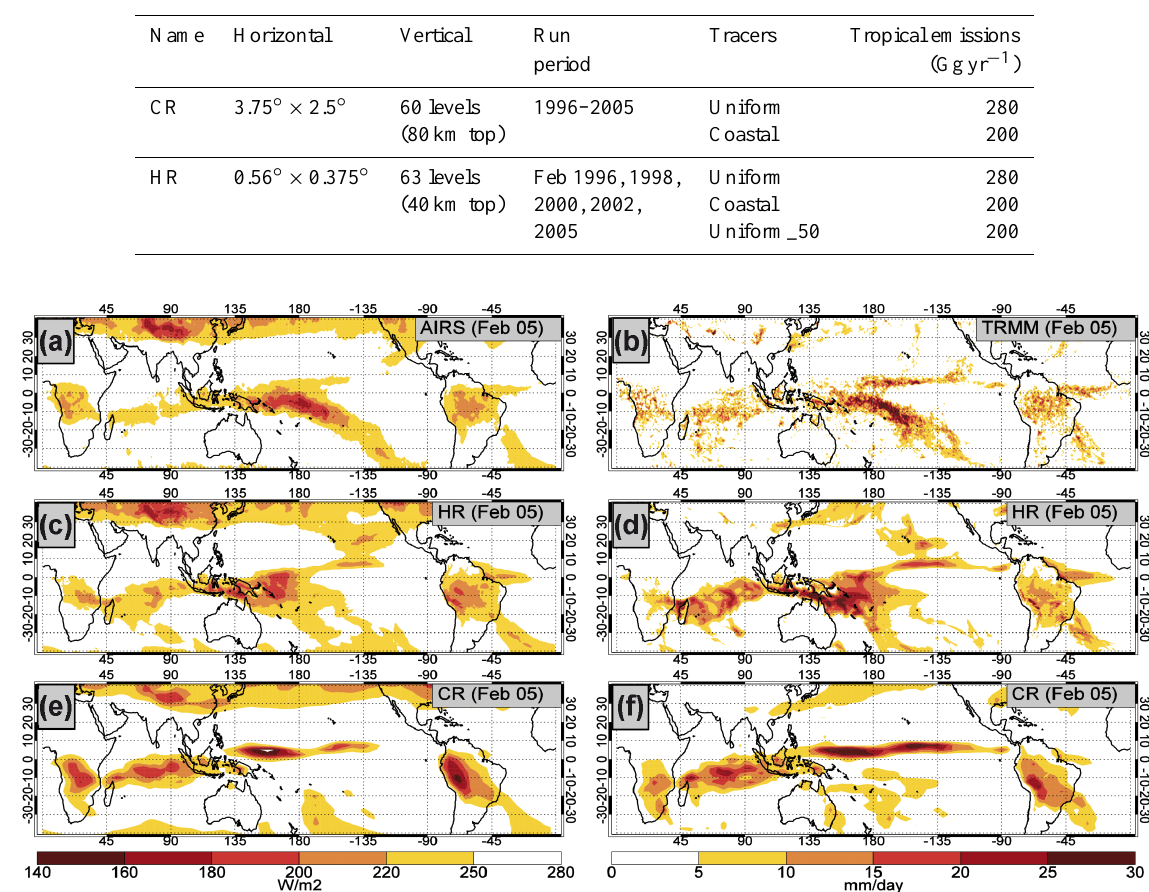
Figure 2. Observed and modelled fields for February 2005: (a) outgoing longwave radiation (OLR) from AIRS in Wm − 2 ; (b) precipitation from TRMM in mmday − 1 ; (c) OLR and (d) precipitation for the high-resolution run; and (e) OLR and (f) precipitation for the coarse- resolution